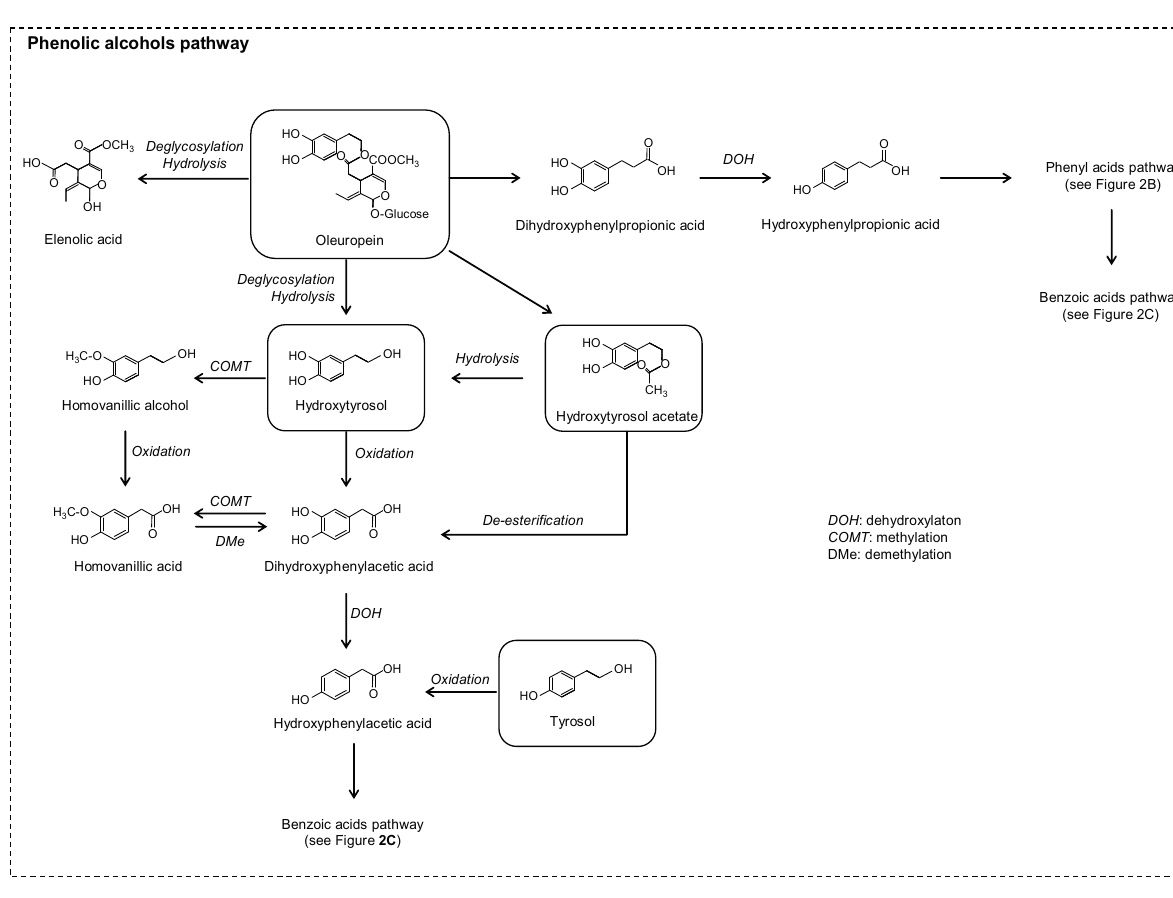
Figure 7. Proposed colonic pathways of